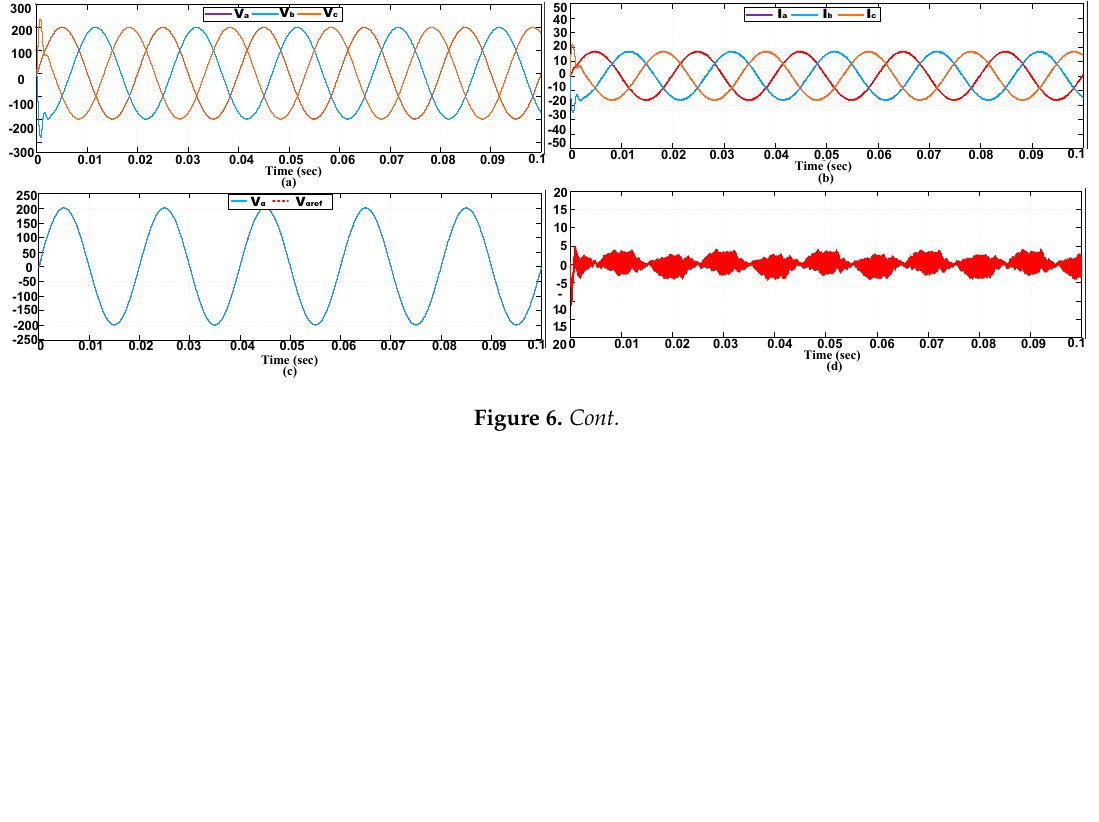
Figure 6. Simulation results with the H ∞ robust controller in steady-state condition. ( a ) Output voltage, ( b ) Load current, ( c ) α -frame voltage waveform, ( d ) Voltage tracking Error, ( e ) Voltage THD, ( f ) Current THD.